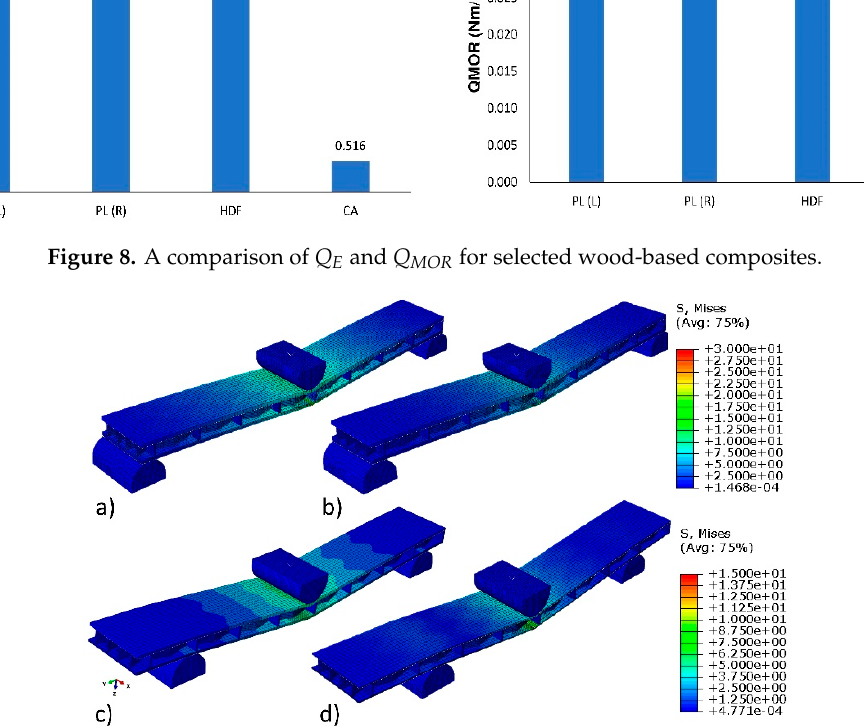
Figure 10. Stiffness characteristics of multilayer beams and ( a ) value of numerical calculations of crack displacement during bending ( b ).